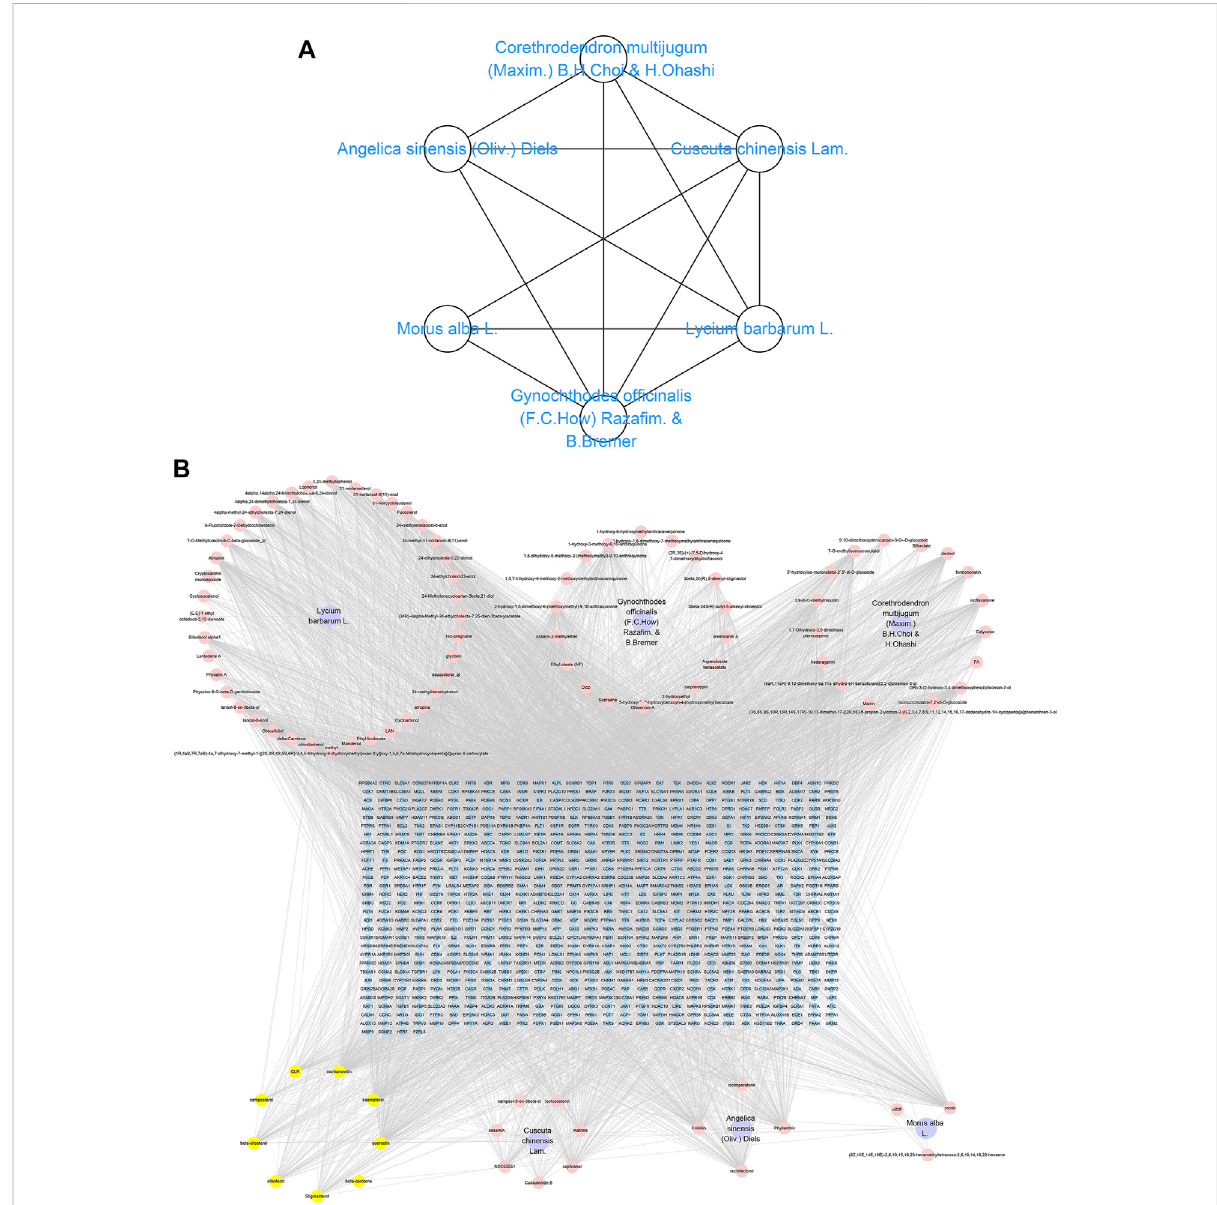
FIGURE 1 CCMM and component-target network. (A) CCMM network. (B) CCMM component-target network. Purple nodes stand for herbs of CCMM. Pink nodes represent bioactive components from each herb. Yellow nodes indicate bioactive components that appear more than once from different herbs. Blue nodes stand for